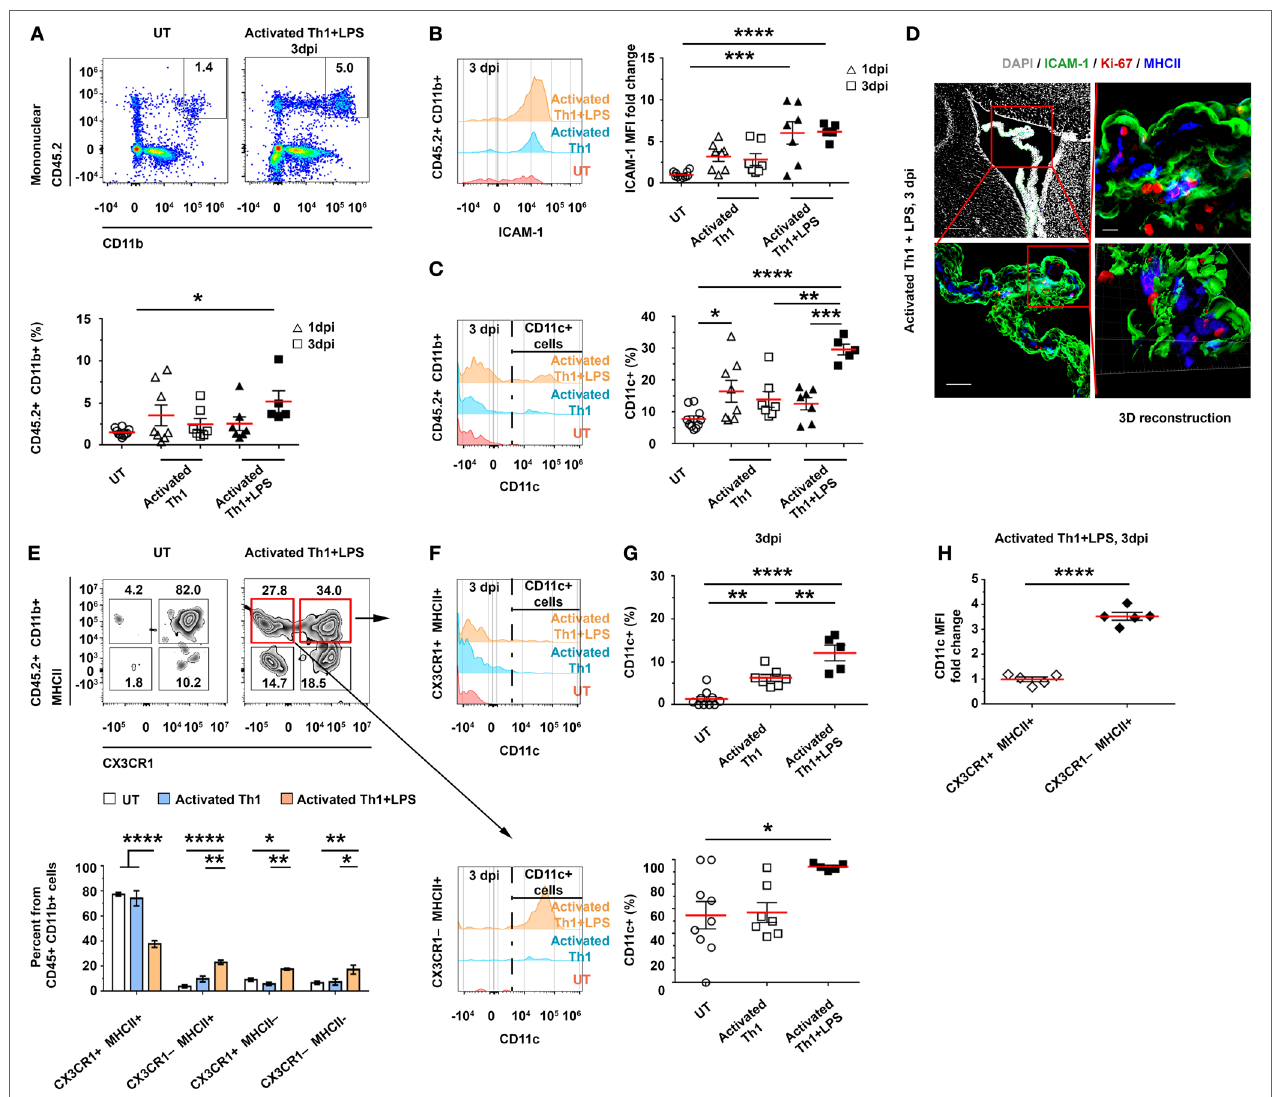
FigUre 3 | CD4 T cells homing to the choroid plexus (CP) locally impact antigen-presenting cell subsets. Activated CD45.1 + Th1 cells were intracerebroventricularly (ICV)-injected into the lateral ventricles (LVs) of either untreated (UT) or lipopolysaccharide (LPS)-preconditioned ( + LPS) CD45.2 wild-type mice. The LV CPs of